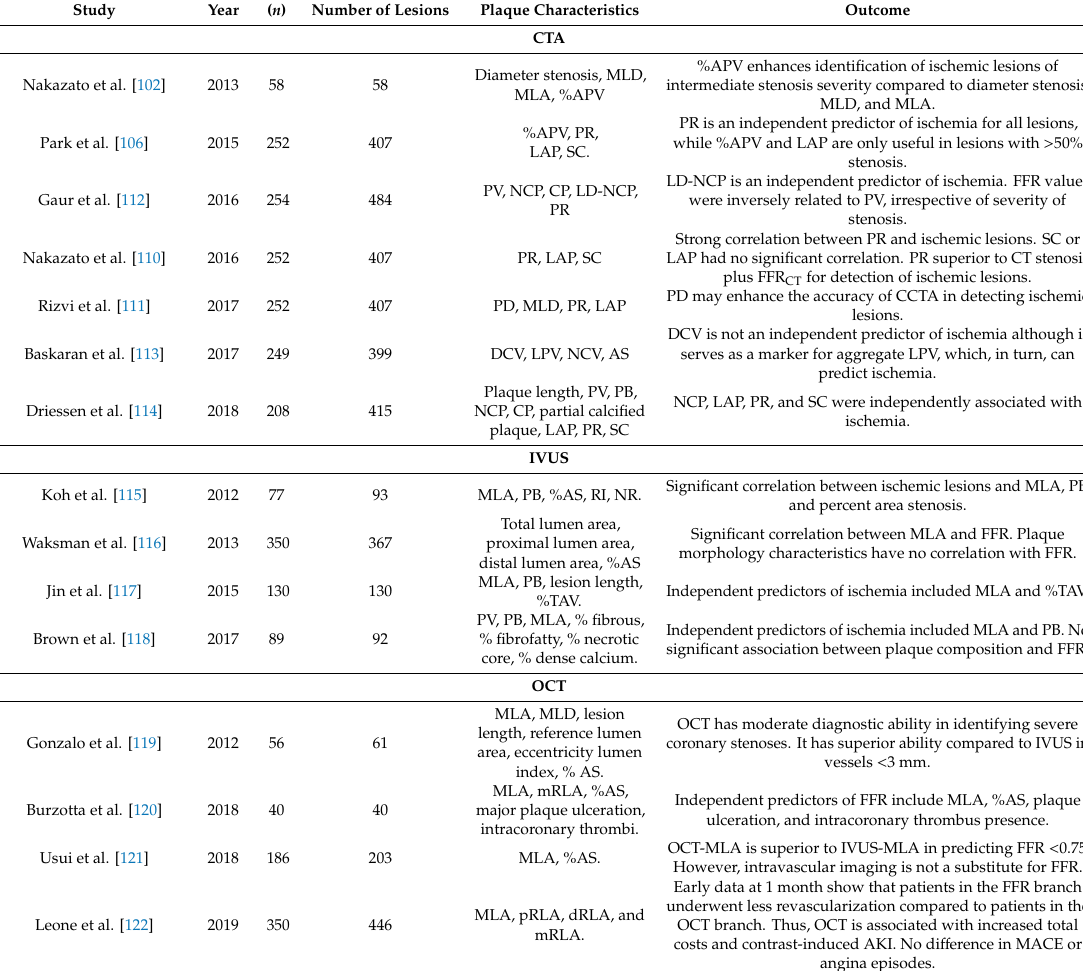
Table 3. Studies linking Plaque Characteristics to